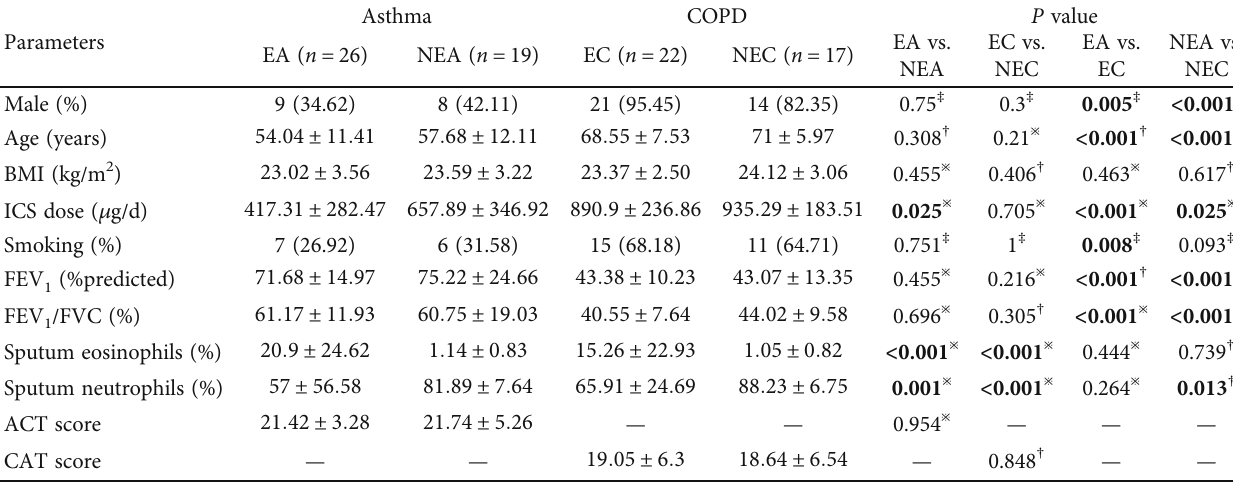
Table 1: Enrolled subjects ’